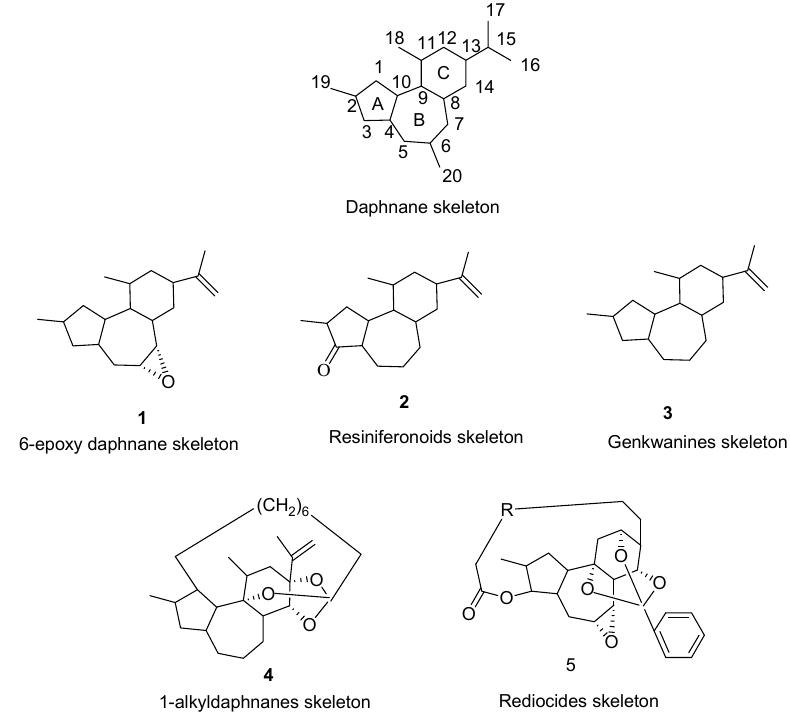
Figure 1. The kinds of daphnane-type diterpenoids skeleton.